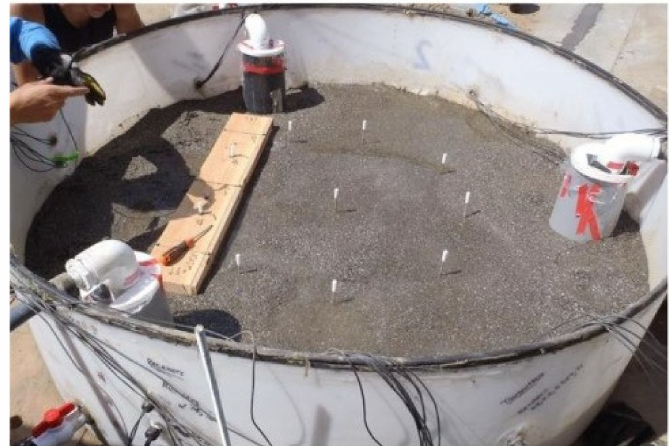
Figure 5. Photos of microbial sand fixation in the field